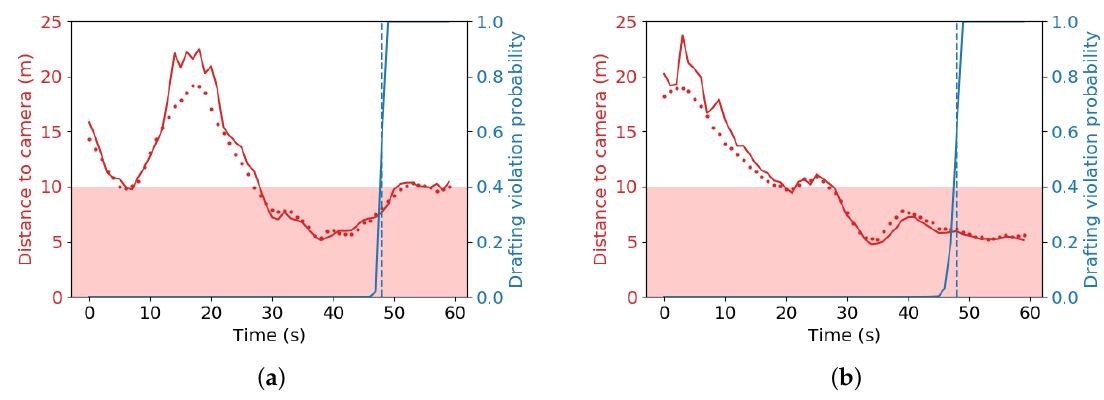
Figure 15. Drafting violation probability in two parts of our dynamic test. The distance to the cyclist was estimated with the HHm (red solid line). The ground truth distances are shown with red dots as markers. The draft zone is colored pink. The evolution of the drafting violation probability is superimposed on the same graphs (blue solid line). A blue dashed vertical line indicates when P ( v 1: n | x 1: n ) > 0.5 for the first time. The sampling period for both the LiDAR and the sampled distance measurements was 1 s . ( a ) Cyclist behind driving to edge of draft zone, then further away, before approaching again and eventually entering the draft zone after approximately 27 s; ( b ) cyclist behind driving to edge of draft zone, stays close to edge, before eventually entering the draft zone after approximately 27